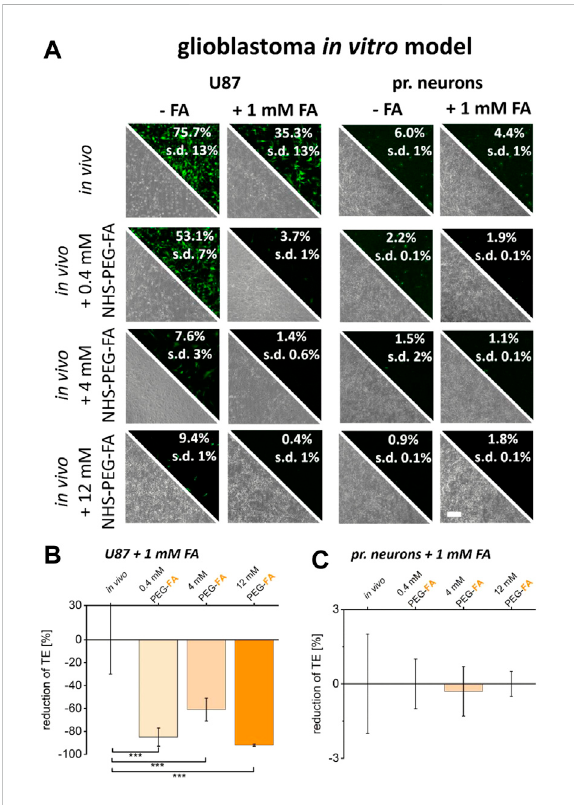
FIGURE 6 Reduction of FA binding capacity and the impact on transfer ef fi ciencies of FA functionalized lipoplexes. To reduce the uptake capacity of PEG-FA functionalized lipoplexes, cancer cells (U87) and healthy primary cortical neurons were pre-incubated with 1 mM FA. The resulting transfer ef fi ciencies were analyzed by fl uorescencemicroscopyand fl owcytometry (A) .Thereductionin transfection ef fi ciencies of FA-functionalized lipoplexes was characterized comparatively between unmodi fi ed in vivo protocols and FA functionalized lipoplexes (0.4 – 12 mM) for cancercells (B) andhealthycells (C) normalizedtothein fl